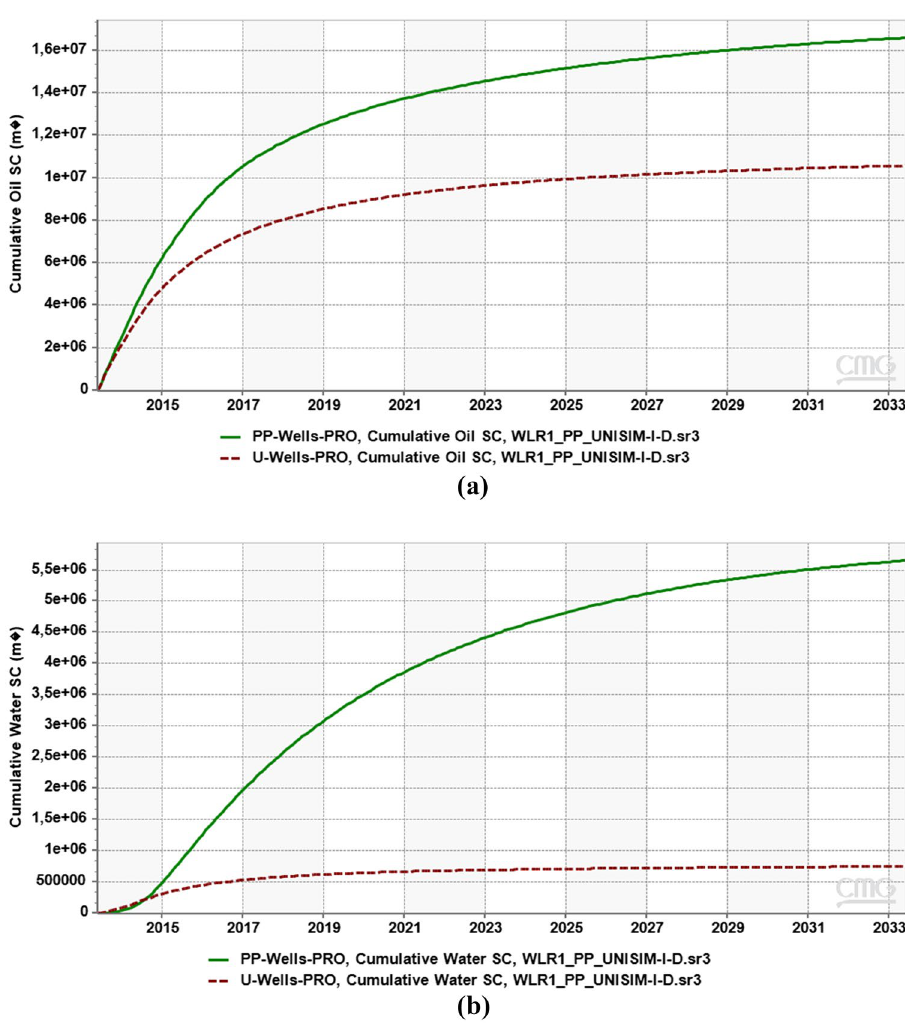
Fig. 8, the NA2 COP is higher than the PP_1, which looks like an inconsistency. From Table 1, it can be seen that the PP NA2 well has a lower C value compared to PP_1, but 4 more perforations than PP_1, in blocks with water satura- = 0.2 tions up to S w . Similarly, NA1A COP performance is better than PP_1 and also PP_3 as it has more perforations = 0.17 blocks with S w than PP_1 and PP_3. Therefore, it can be seen that although NA1A and NA2 wells have a lower PP ∩ PP C L values, the number of perforations in low water (high oil) saturations may overcomes the oil recovery per- PP ∩ PP formance compared to wells with better C L values, but a lower number of perforations.